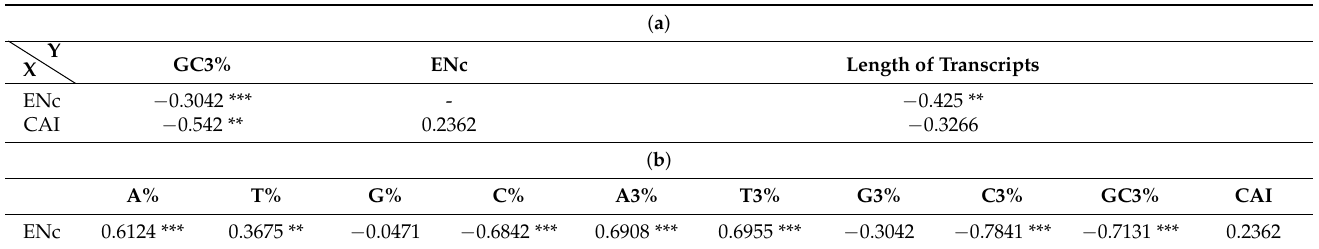
Figure 5. Parity analysis showing preference of purine over pyrimidine. A disproportionate distribution shows the preference towards codon choices is shaped by both mutational pressure and natural selection. Table 4. ( a ) Correlation analysis between GC3%, ENc, CAI, and length of transcripts. ( b ). Correlation between the ENc and compositional properties of the EPB41L3 gene transcripts was performed to de-termine the effect of nucleotide bases on the CUB. The positive correlation between the ENc and A, A3, and T3 and negative correlation between C, C3, and GC3 inferred the role of both natural selection and mutation pressure on the CUB in the EPB41L3